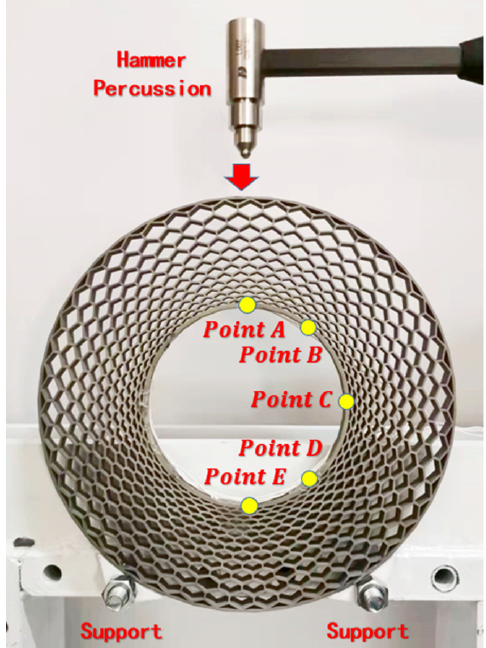
Figure 3. Diagram of the test device.